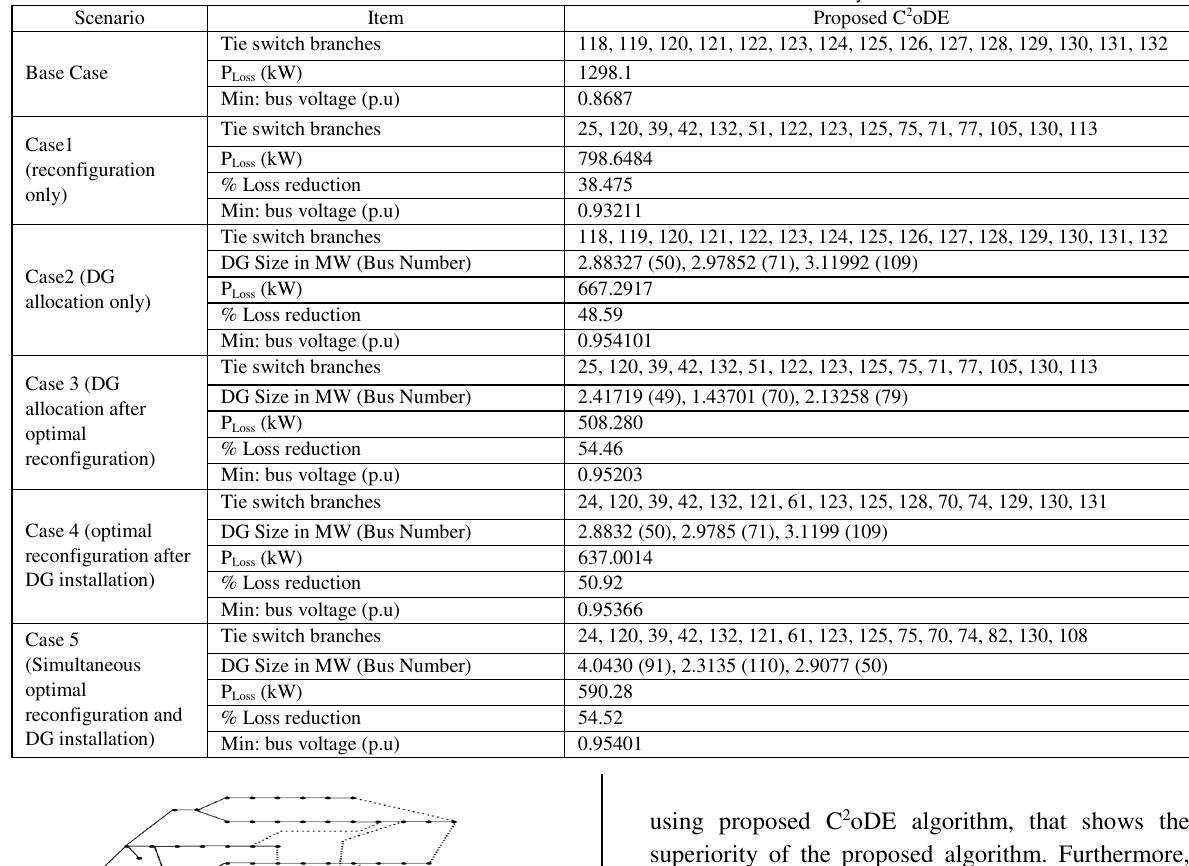
Table 8: Simulation Results of Case 1 to Case 5 for 119-Bus System